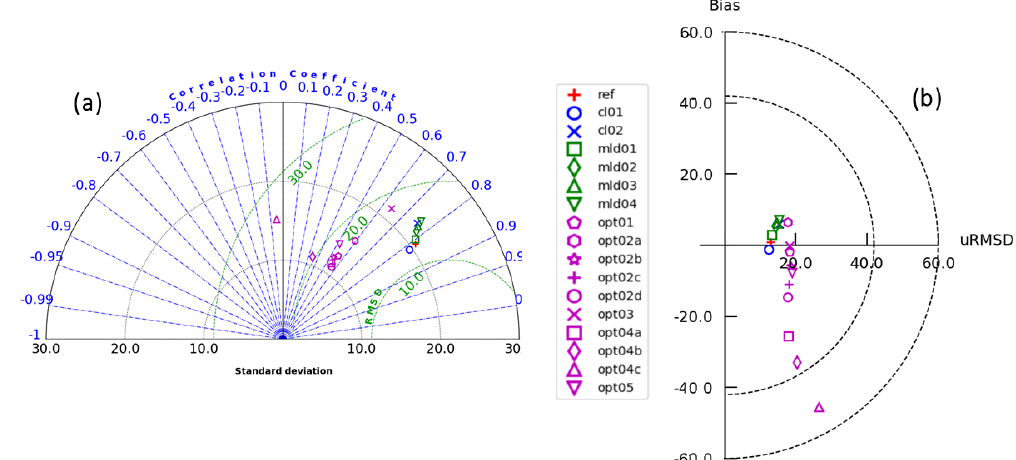
Figure 8. (a) Taylor diagram showing model skill in reproducing DCM depth compared to data. Correlation is represented by the angle with a positive x axis, whereas distances from the origin depict standard deviations. Green circles illustrate iso-contours of RMSD levels; all units are in metres. (b) Target diagram showing model skill in reproducing DCM depth compared to data. Distance to the origin defines the RMSD; all units are in metres. The position on the x axis is positive if the model standard deviation is higher than the one from data results and negative in the opposite situation. For the sake of completeness, all models considered are reported in these summarizing skill